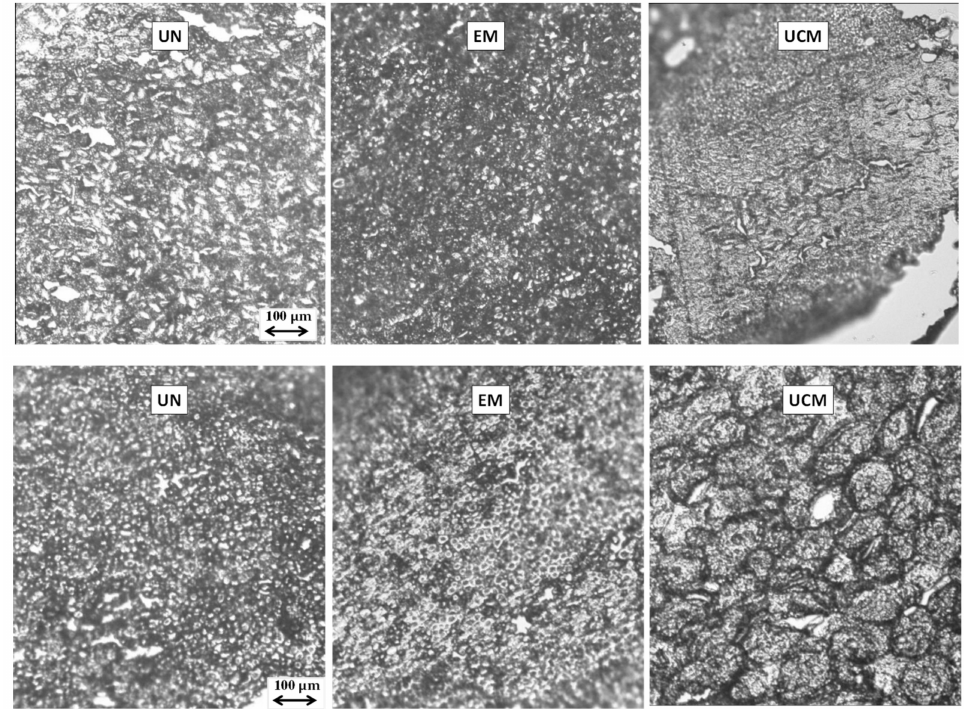
Figure 2. Images performed at optical microscope (10 × objective) of transversal layers of 5 µ m, cut from UN, EM, and UCM durum wheat grains ( up ) and corn grains ( down ), first immersed in water for 17 h and then frozen at − 20 ◦